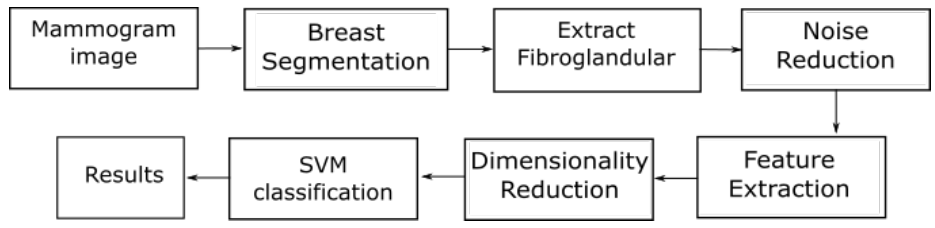
Figure 2. An overview of the proposed breast density